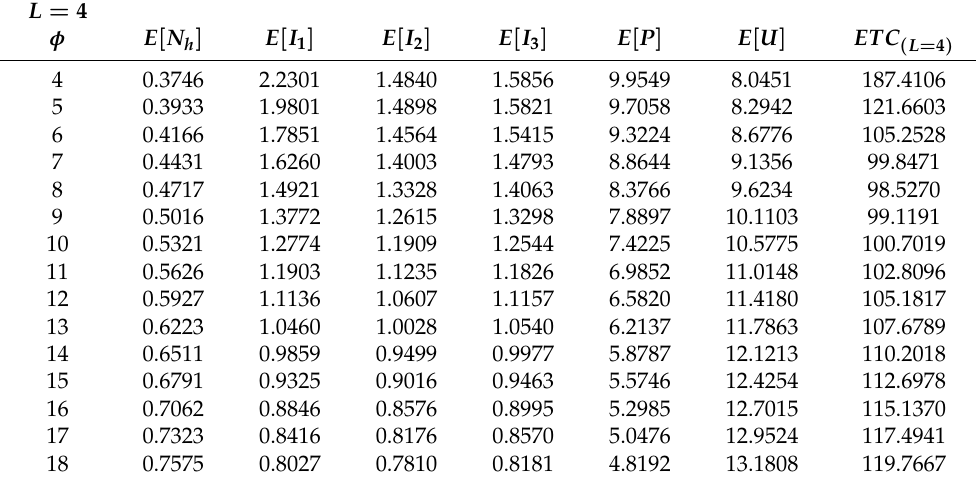
Table 9. Effect of φ on various performance measures and ETC per unit time ( L = 4).